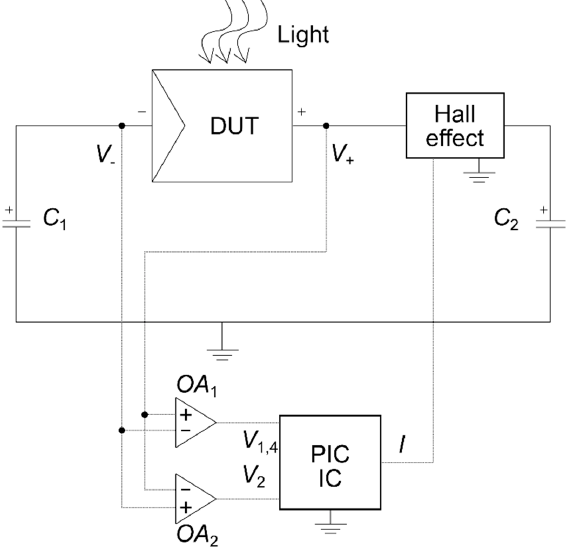
Figure 12. Voltage and current measure schematic for the I-V tracer.